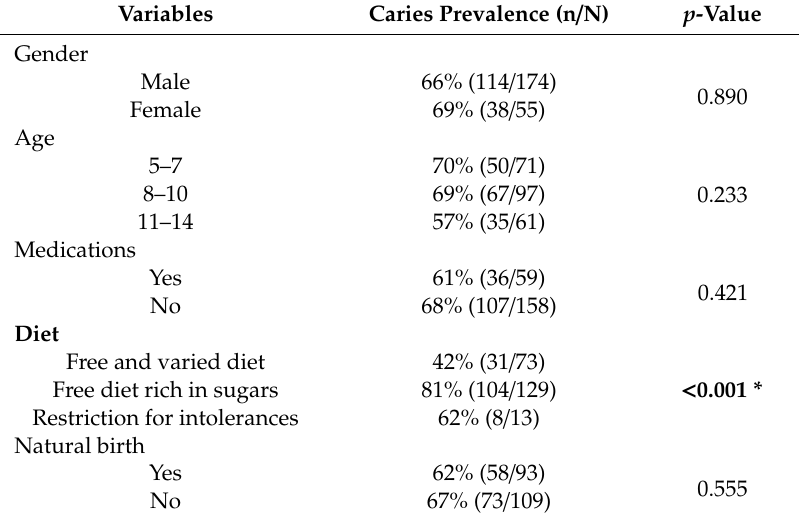
Table 2. Caries prevalence in relation to background and behavioral variables. N = total number of participants in each category; n = number of participants with positive DMFT / dmft in each category. p -values < 0.05, corresponding to statistically significant di ff erences, are marked with an asterisk and the corresponding variable is highlighted in bold.